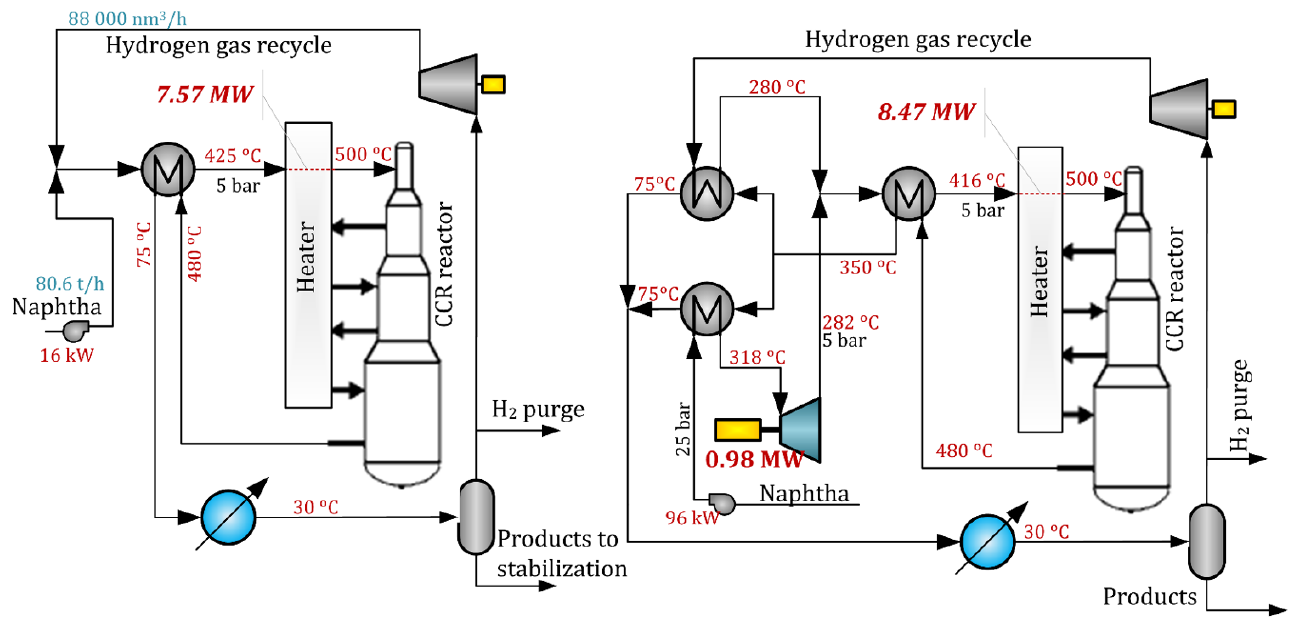
Figure 11. Integration of a turboexpander into the reaction section of naphtha reforming.